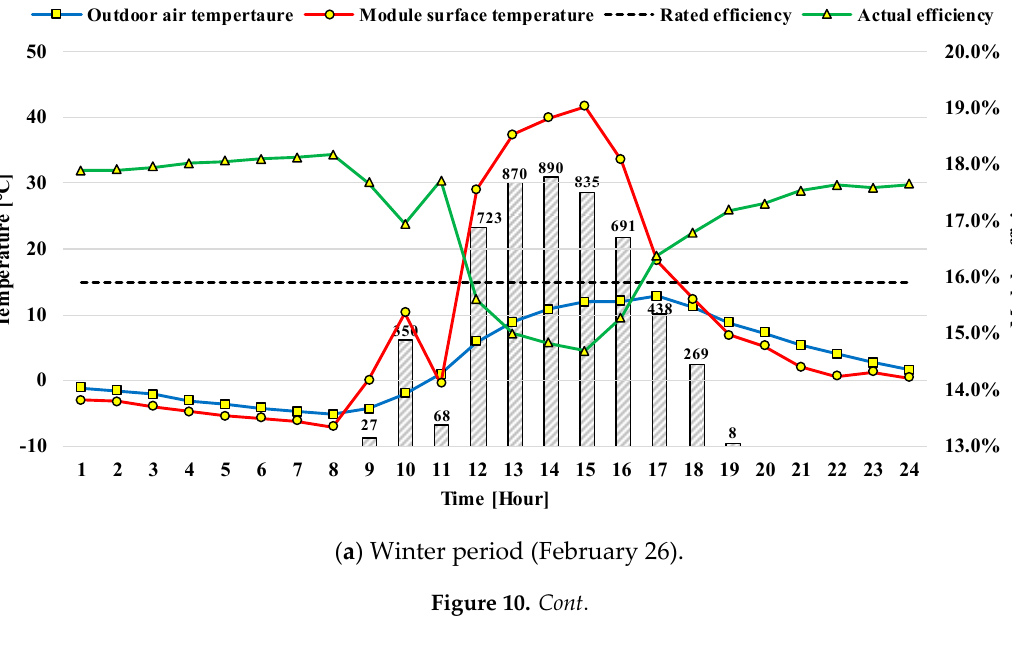
Figure 9. Comparison of the measured and predicted module surface temperatures.